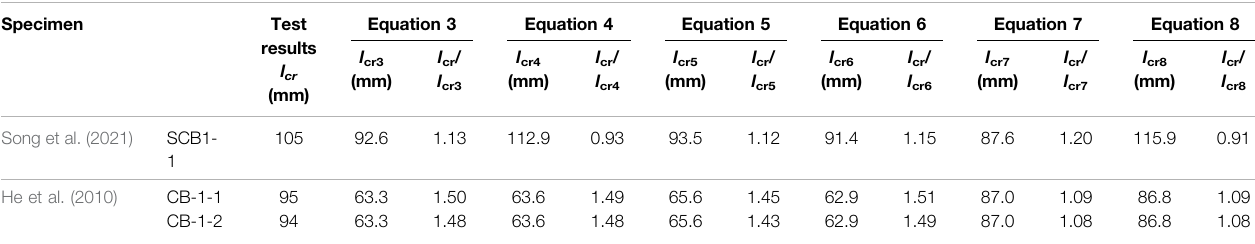
TABLE 2 | Comparison of experimental and modeling results.